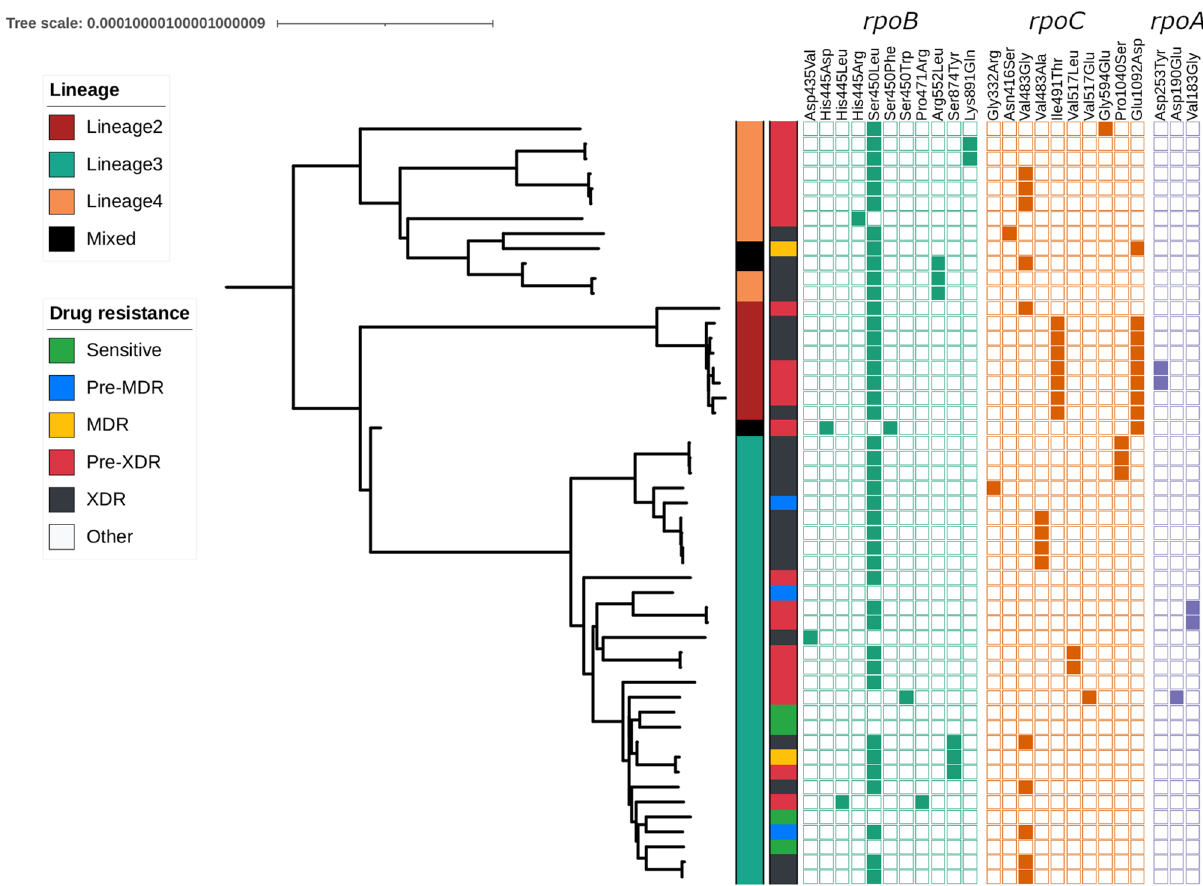
Figure 1. Phylogenetic tree of M. tuberculosis strains (n = 51), with their lineages, multi-drug resistance profiles and specific mutations in rpoB, rpoA, and rpoC . The phylogenetic tree was created using a maximum likelihood approach. The first vertical band to the right of the tree denotes the lineage. The second vertical band denotes the drug resistance phenotype. The squares show the presence of a specific